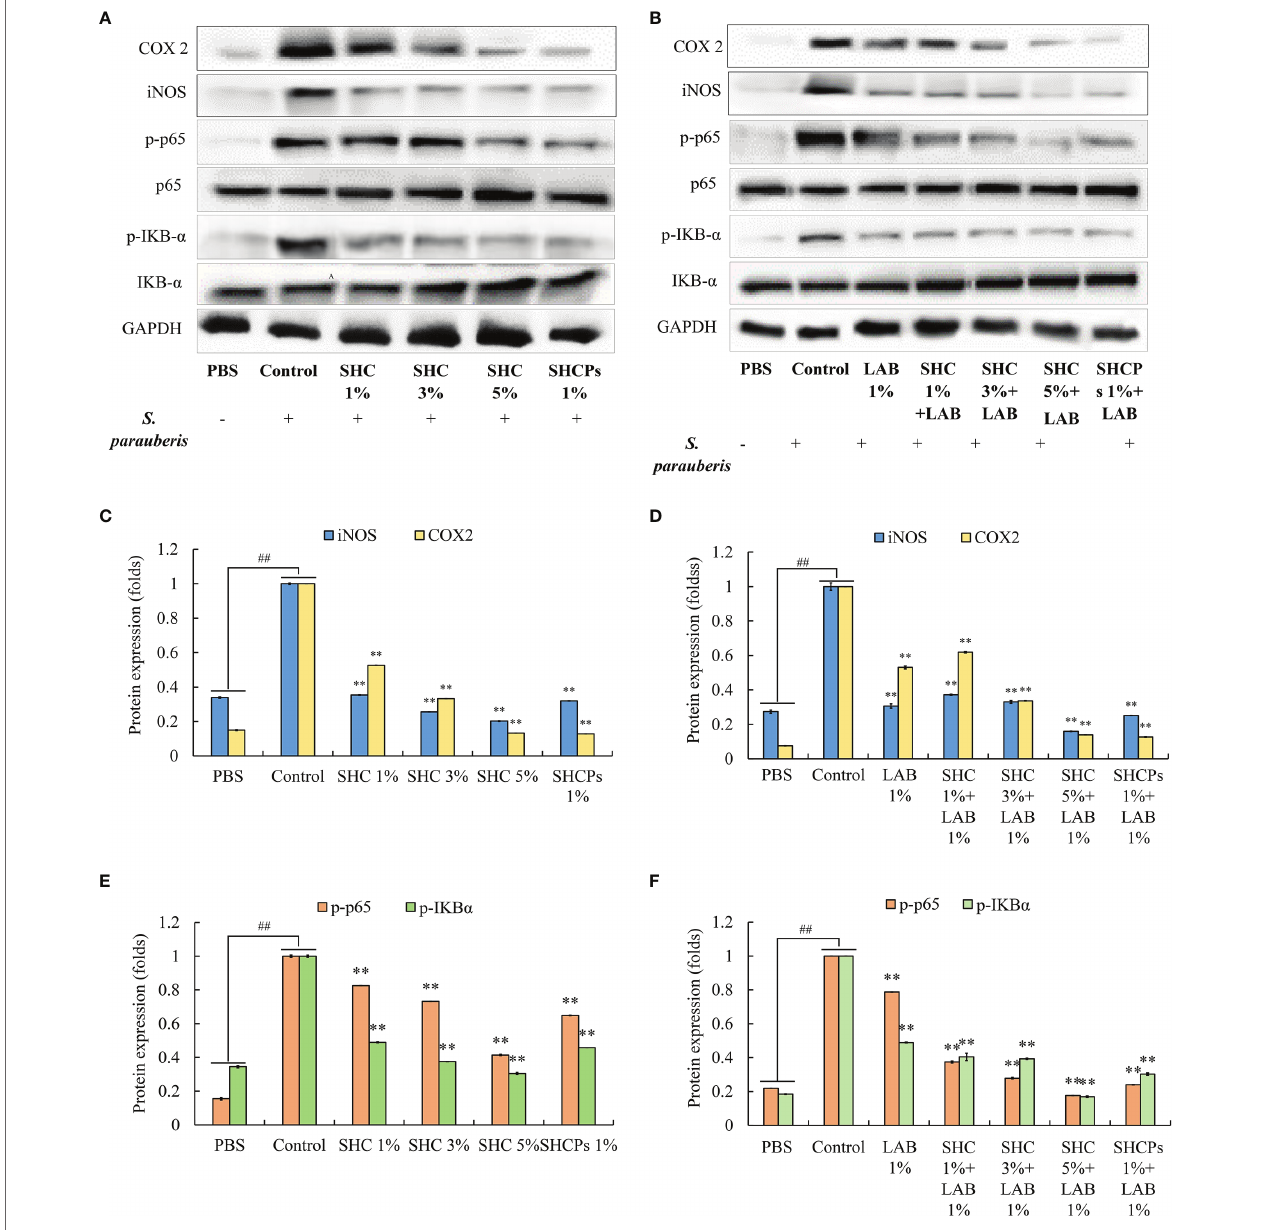
FIGURE 5 | Effect of experimental diet on expression levels of inflammatory mediators and NF- κ B pathway related proteins. (A, B) Protein expression inhibition by SH extracts, (C, D) iNOS and COX-2 expression (E, F) NF- κ B pathway protein expression. Statistical evaluation was done to compare the experimental and control groups. Values are significantly different from control group at **p<0.01 or ## p < 0.01 compared to non-treated group (PBS